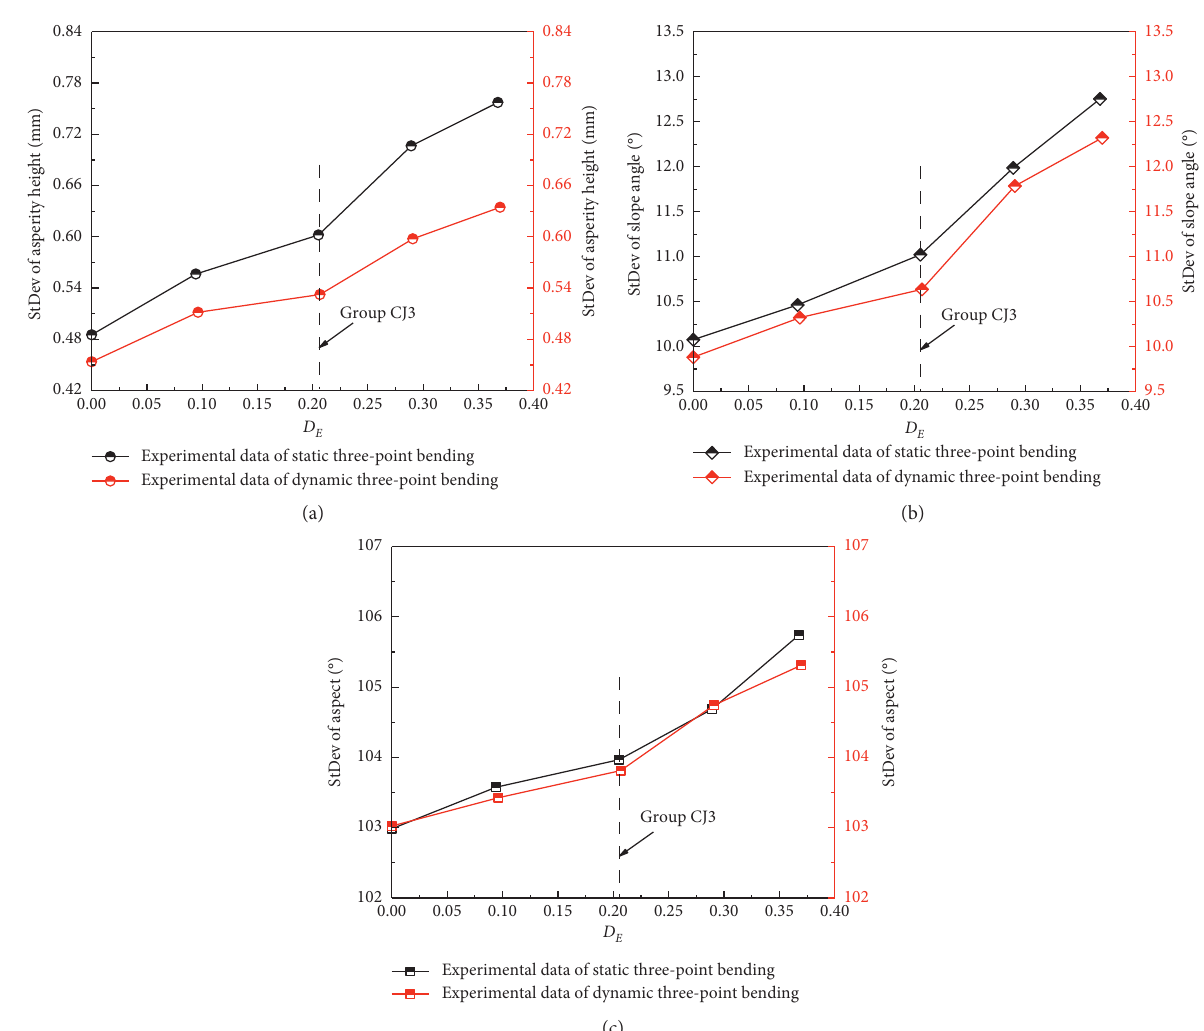
Figure 13: Variations in StDev of 3D spatial distribution parameters with DE. (a) Asperity height (b) Slope angle. (c) Aspect